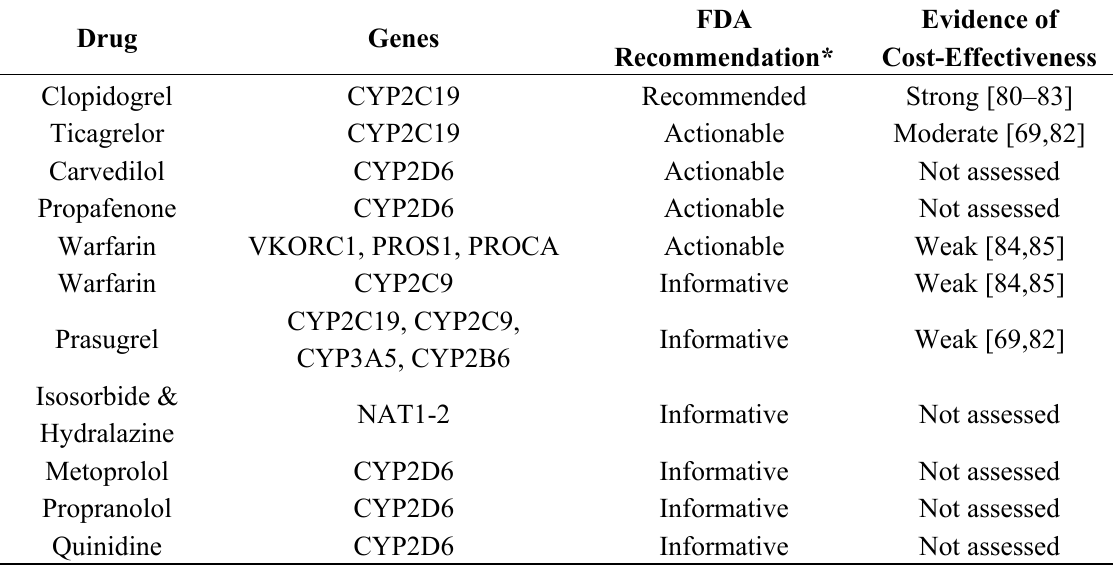
Table 2. FDA-approved drugs with pharmacogenomic information relevant to cardiology care. Drug